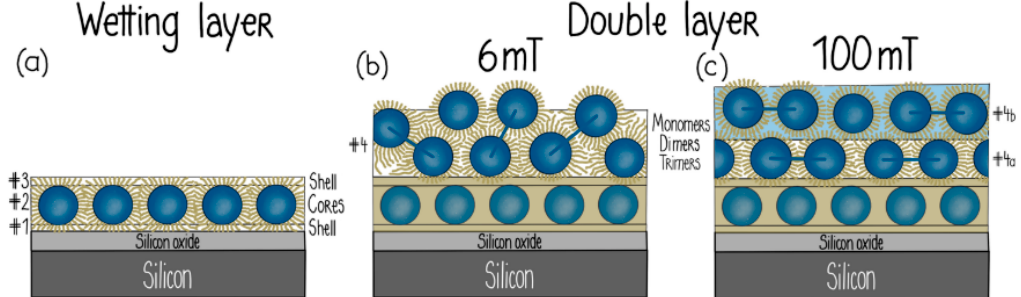
Figure 22. Schematic drawing of magnetic nanoparticle (NP) ordering determined for the first layers above the silicon surface, based on results from SANS and PNR. ( a ) Wetting layer, ( b ) double layer on top of the wetting layer in a magnetic field of 6 mT, and ( c ) double layer on top of the wetting layer in a magnetic field of 100 mT. The magnetic field is directed parallel to the surface. (Reprinted with permission from [186]. Copyright 2018 American Chemical Society).